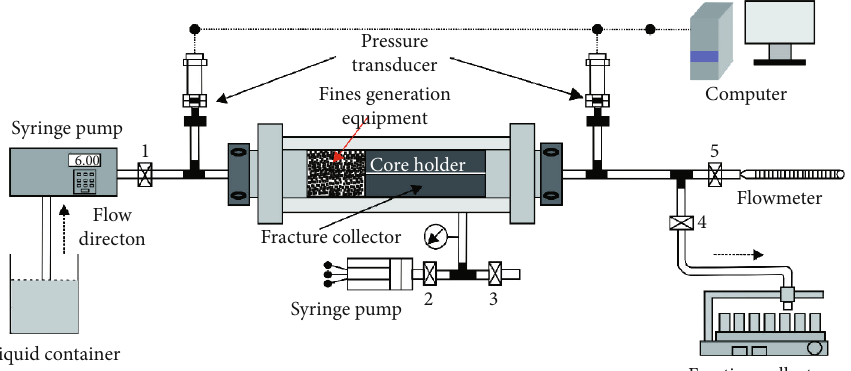
Figure 3: Schematic con fi guration of experimental apparatus for coal fi nes intrusion